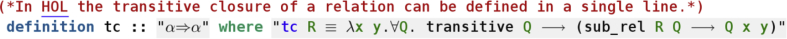
Higher-order definition of the transitive closure of a relation; encoding in Isabelle/HOL.